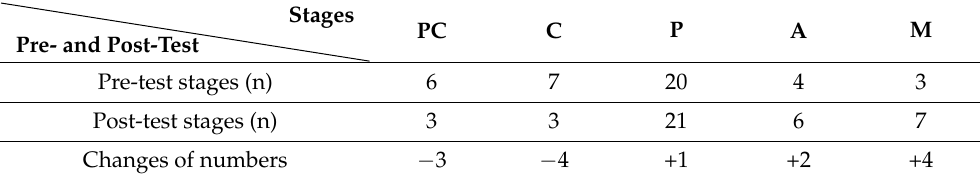
Table 5. Change of TTM stage (N =